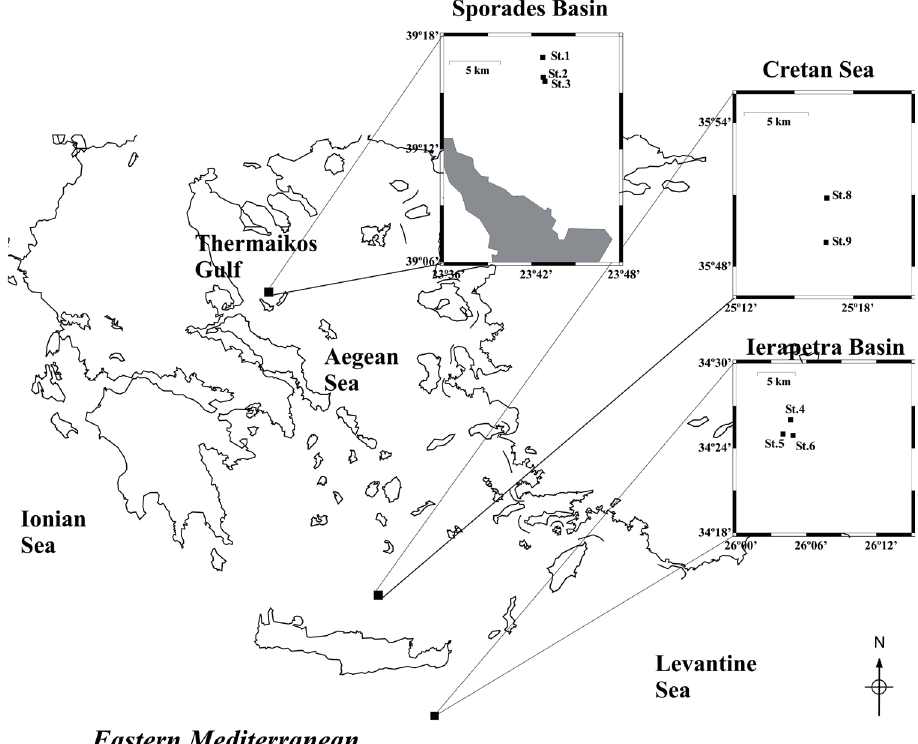
Fig . 1. – sampling area and location of stations (sporades Basin: stations 1, 2, and 3; Cretan sea: stations 8 and 9; ierapetra Basin: stations 4, 5, and Table 1. – station list for the three sampling areas (temp.: sediment temperature; eh: redox potential at 1 cm depth; md: median diameter of the sediment; σ 1: sediment sorting coefficient; s&C: percentage of silt and clay).